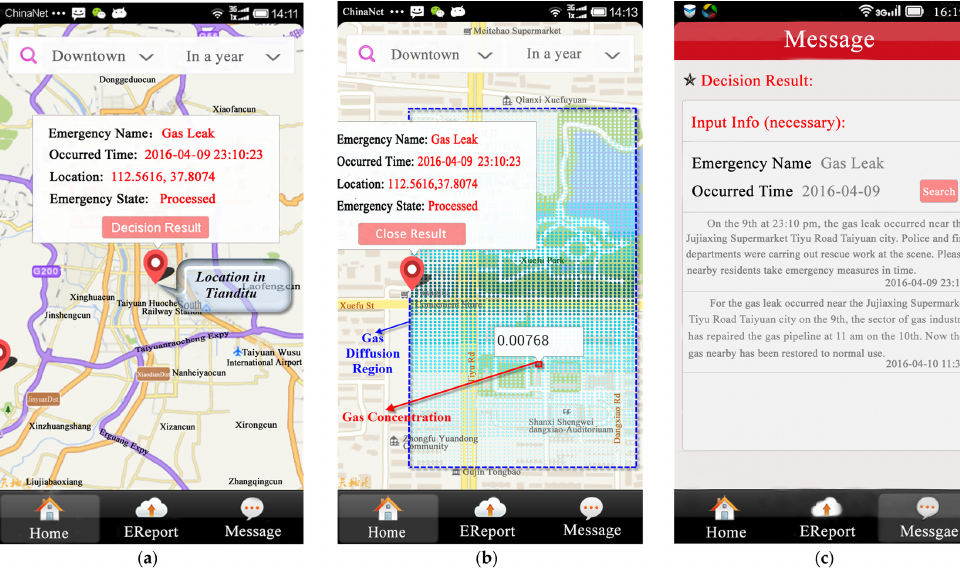
Figure 10. Android mobile terminal visualization of the gas concentrations monitoring for the gas leak emergency response: ( a ) the visualization of the gas leak event; ( b ) the decision result of the gas concentrations monitoring; and ( c ) the announcement messages for the gas leak emergency responses.